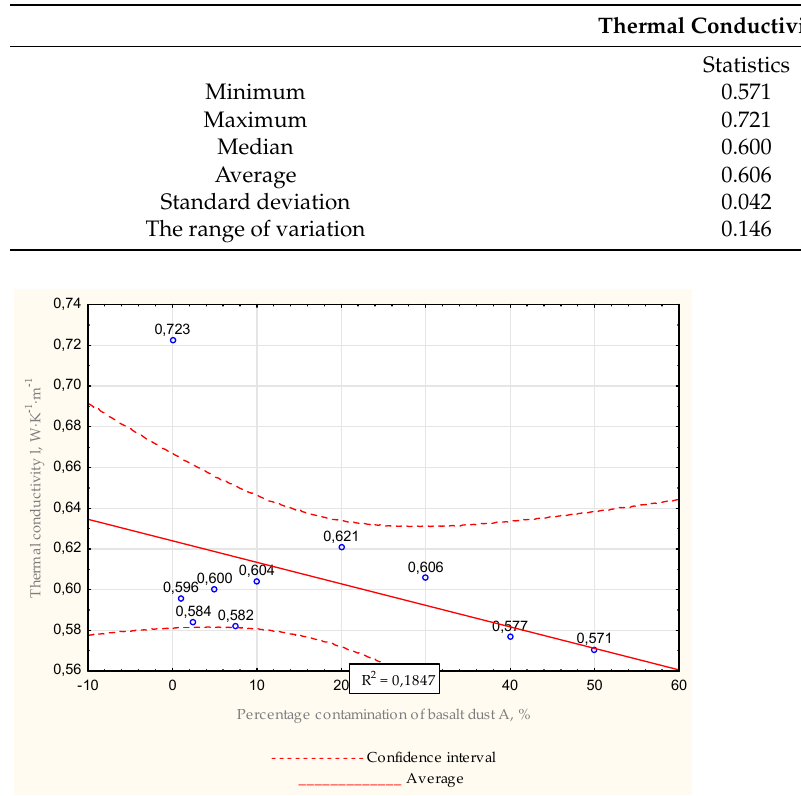
Figure 9. Average thermal conductivity for basalt dust A for water − mix ratio = 0.5.